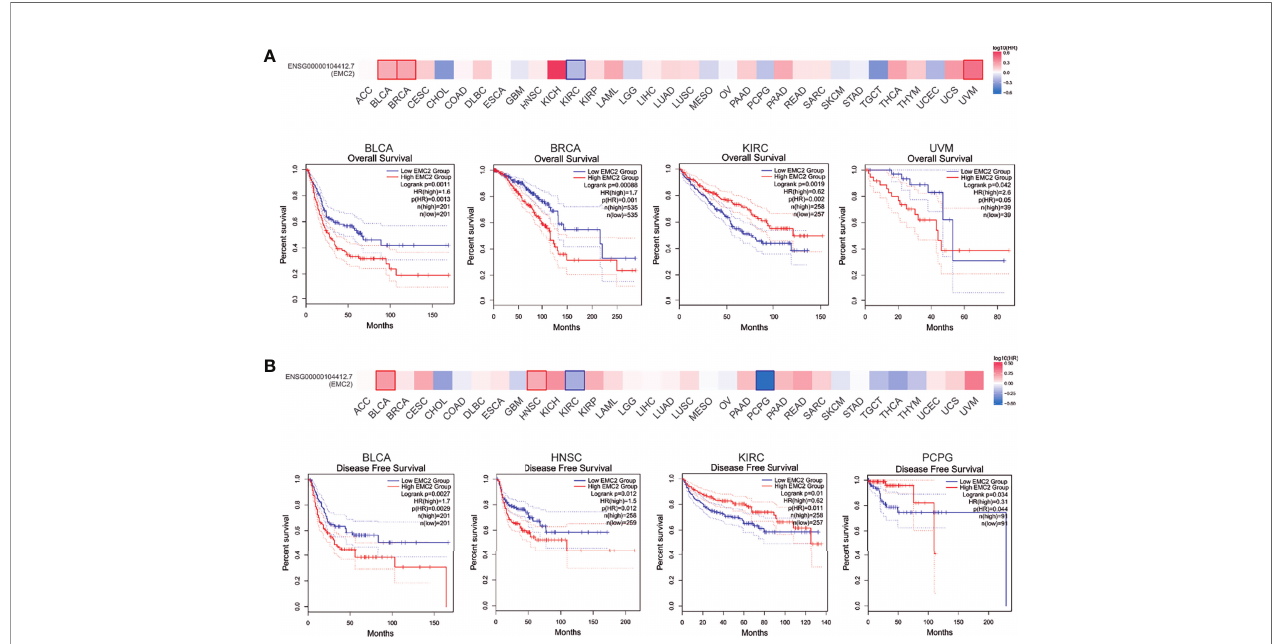
FIGURE 2 | Correlation between EMC2 gene expression and survival prognosis of cancers in TCGA. We used the GEPIA2 tool to perform overall survival (A) and disease free survival (B) analyses of different tumors in TCGA by EMC2 gene expression. The survival map and Kaplan-Meier curves with positive results are